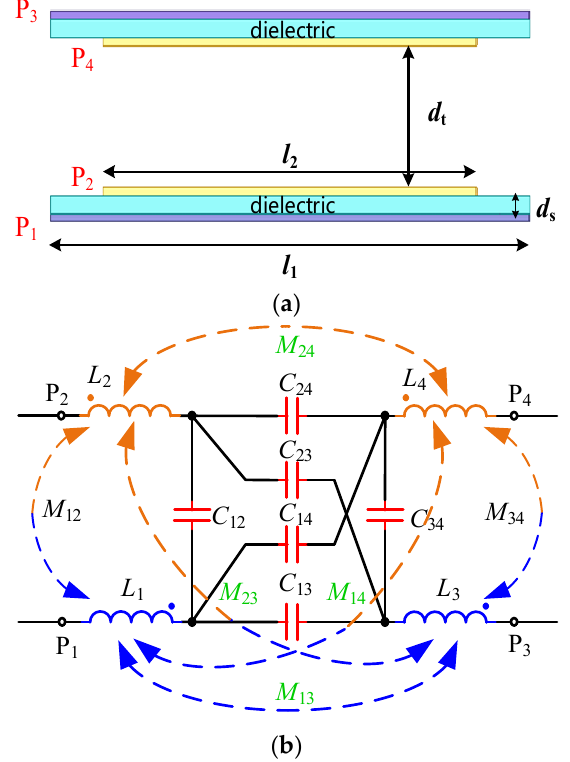
Figure 1. Basic structure of integrated electromagnetic coupler. ( a ) 3D Graph of integrated electro- magnetic coupler. ( b ) Top view of plane rectangular spiral electromagnetic pole.